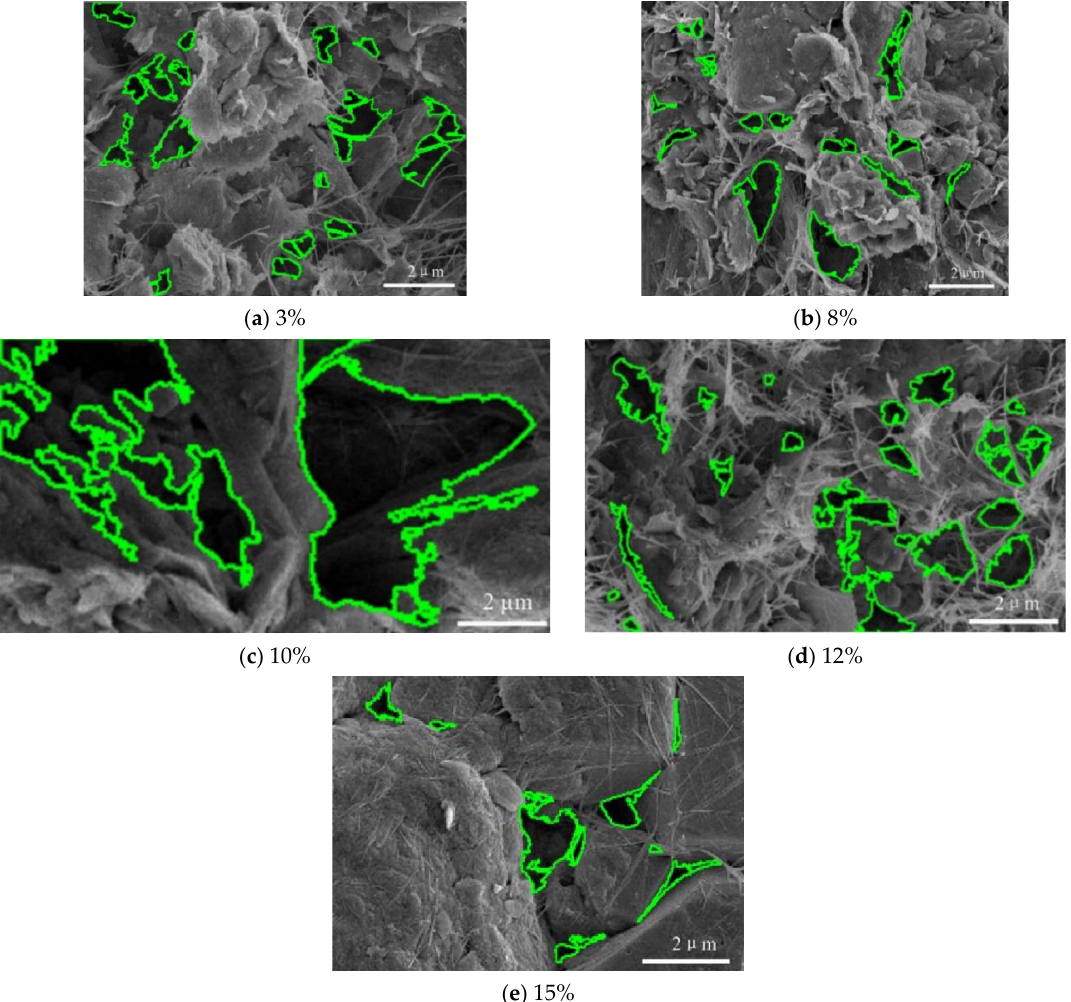
Figure 6. Microstructure characteristics of SN-1 under different absorption conditions. Table 3. Pore structure parameters of SN-1 mudstone samples.